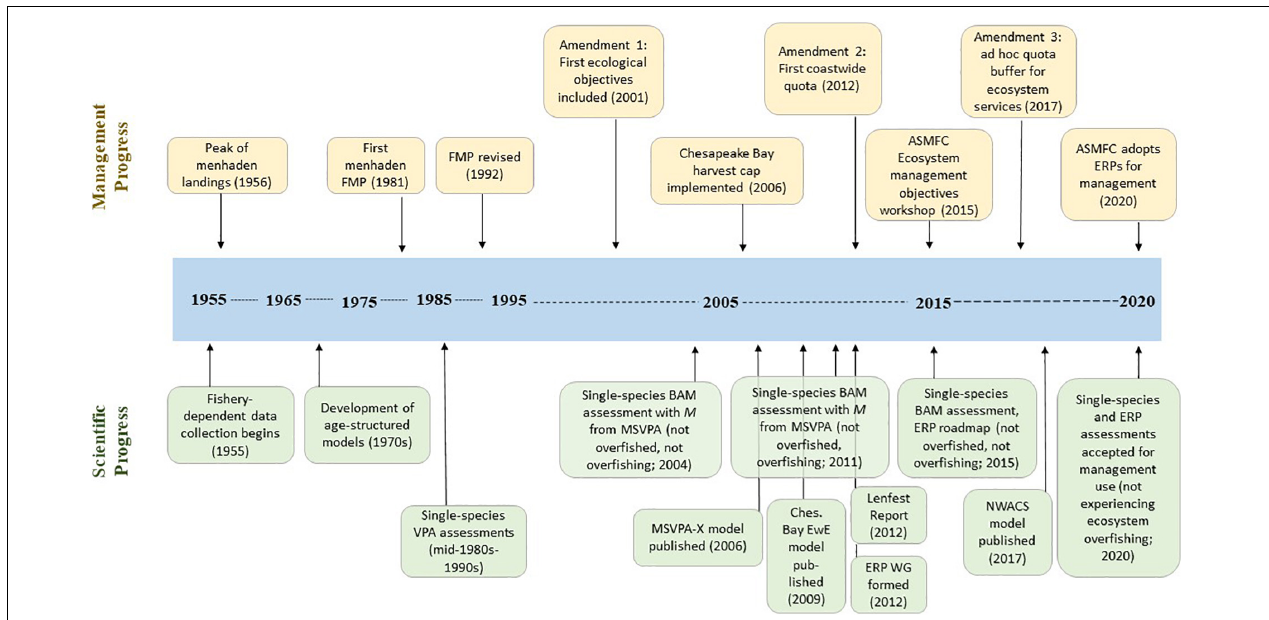
FIGURE 4 | Timeline of significant steps in management and science for Atlantic menhaden and the development of ecological reference points